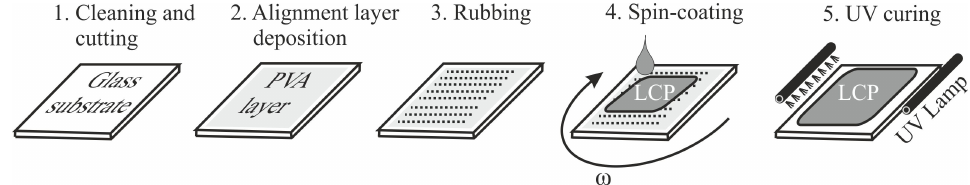
Figure 2. Manufacturing process flow of the LCP